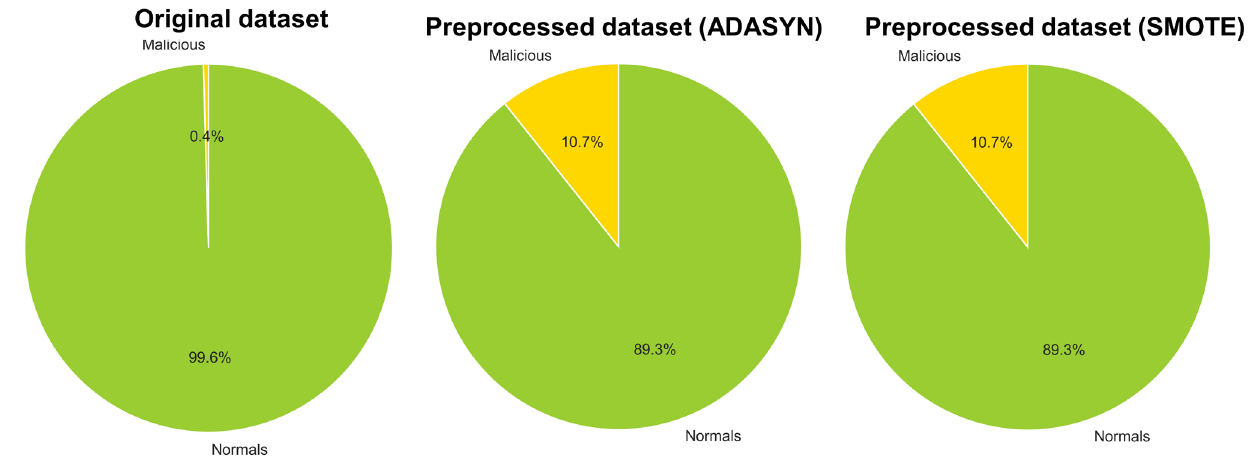
Figure 6. Data ratio pie graphs.